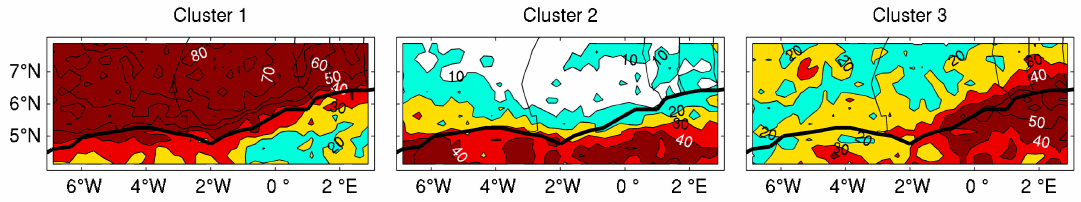
Figure 8. Percentage of intense local rainfall events pertaining to each